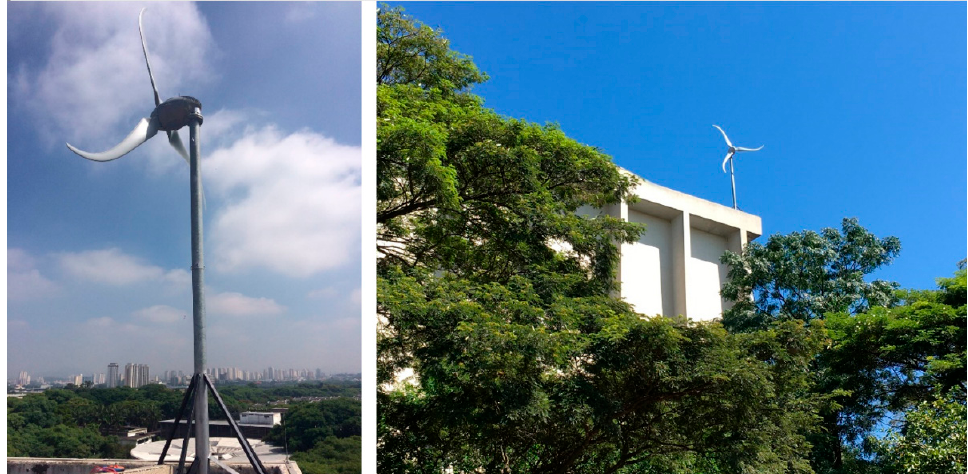
Figure 11. Implantation of the small wind turbine on the rooftop of the selected building.